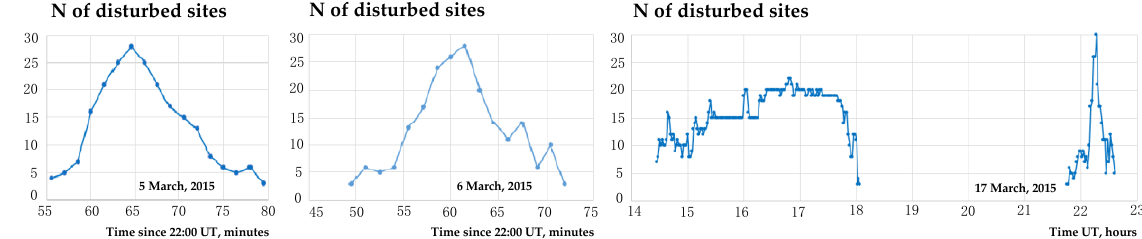
Figure 5. Dependency of number of disturbed sites on time (UT) for 5, 6, and 17 March.